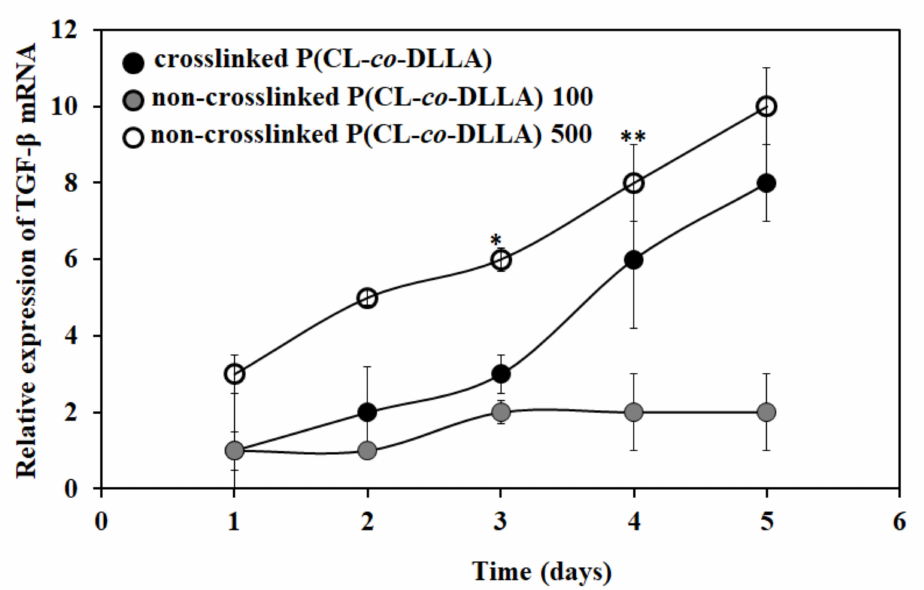
Figure 3. Relative expression of TGF- β mRNA in MCF-7 cells on P(CL- co -DLLA) (crosslinked and non-crosslinked) substrates at di ff erent time periods. The expression of TGF- β mRNA is increased in crosslinked P(CL- co -DLLA) and non-crosslinked P(CL- co -DLLA) 500 substrates. The data were normalized to GAPDH as the exogenous control. Each data represents n = 3 ± SD, where * p = 0.05 and ** p = 0.01fornon-crosslinkedP(CL- co -DLLA)substrateregardstocrosslinkedP(CL- co